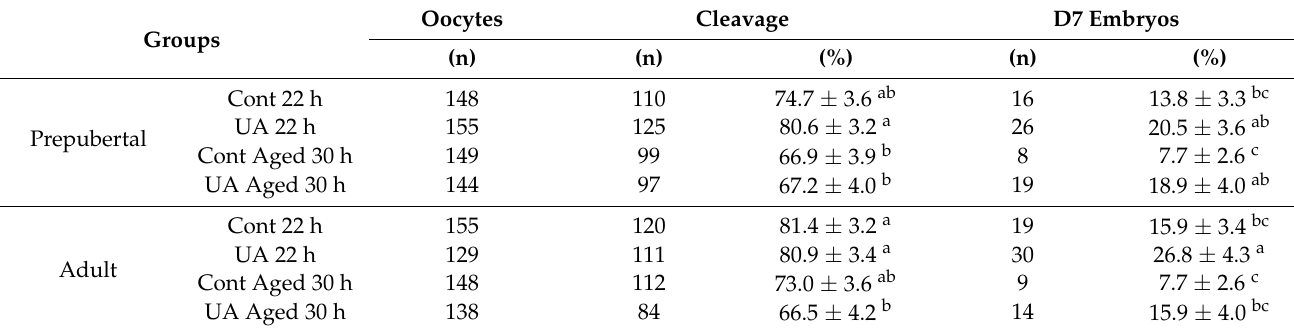
Different letters indicate significant differences between groups ( p ≤ 0.05). Data are expressed as the mean ± standard error mean